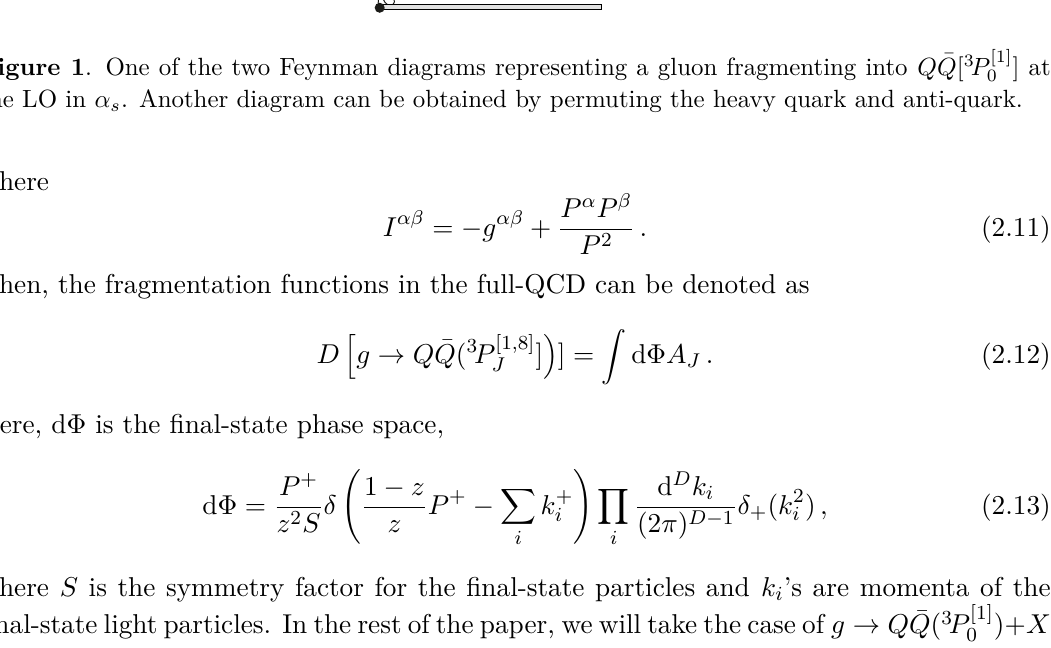
Figure 1 . One of the two Feynman diagrams representing a gluon fragmenting into Q ¯ Q [ 3 P [1]